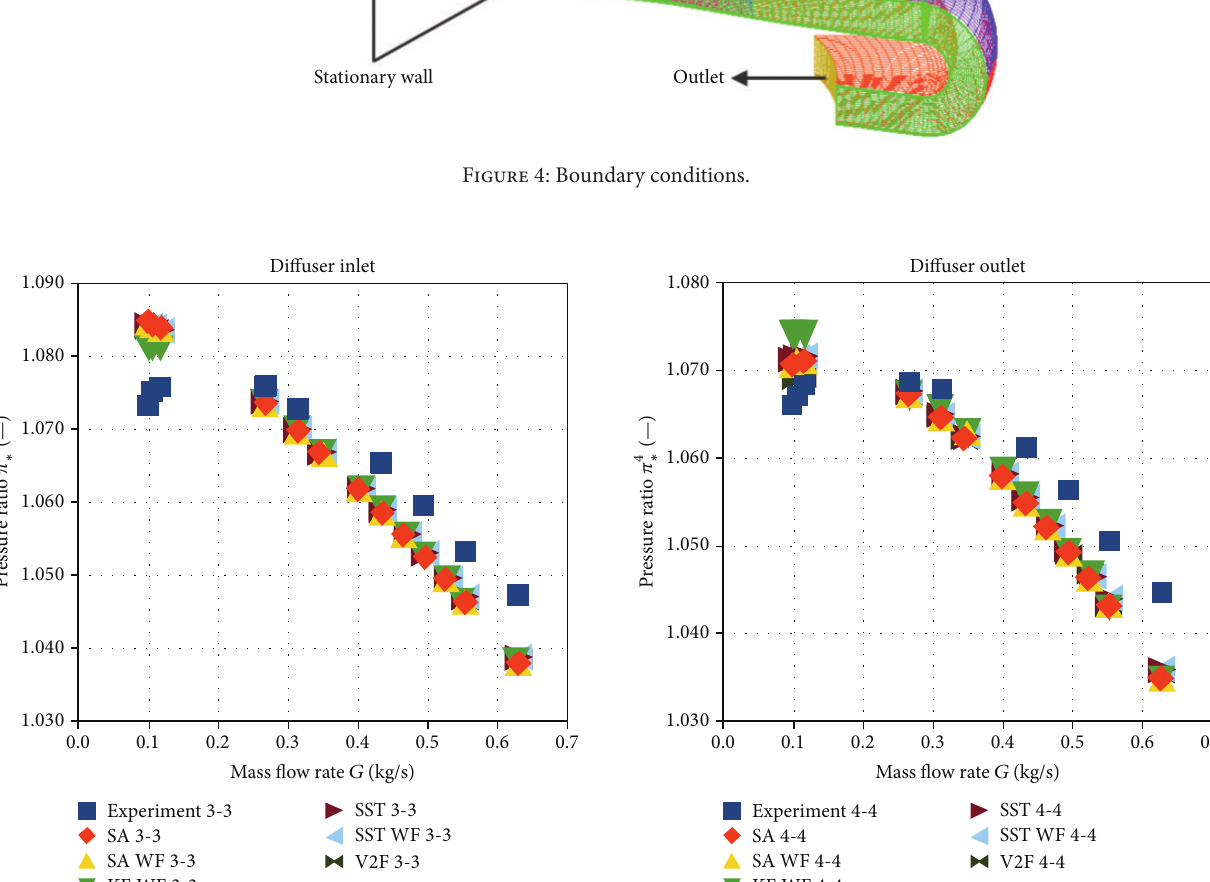
respectively. Thus, the time step for the coarse mesh was equal to 2.7𝑒 − 05 s (twenty iterations in the period) and 5.4𝑒 − 06 s (one hundred iterations in the period) for the refined